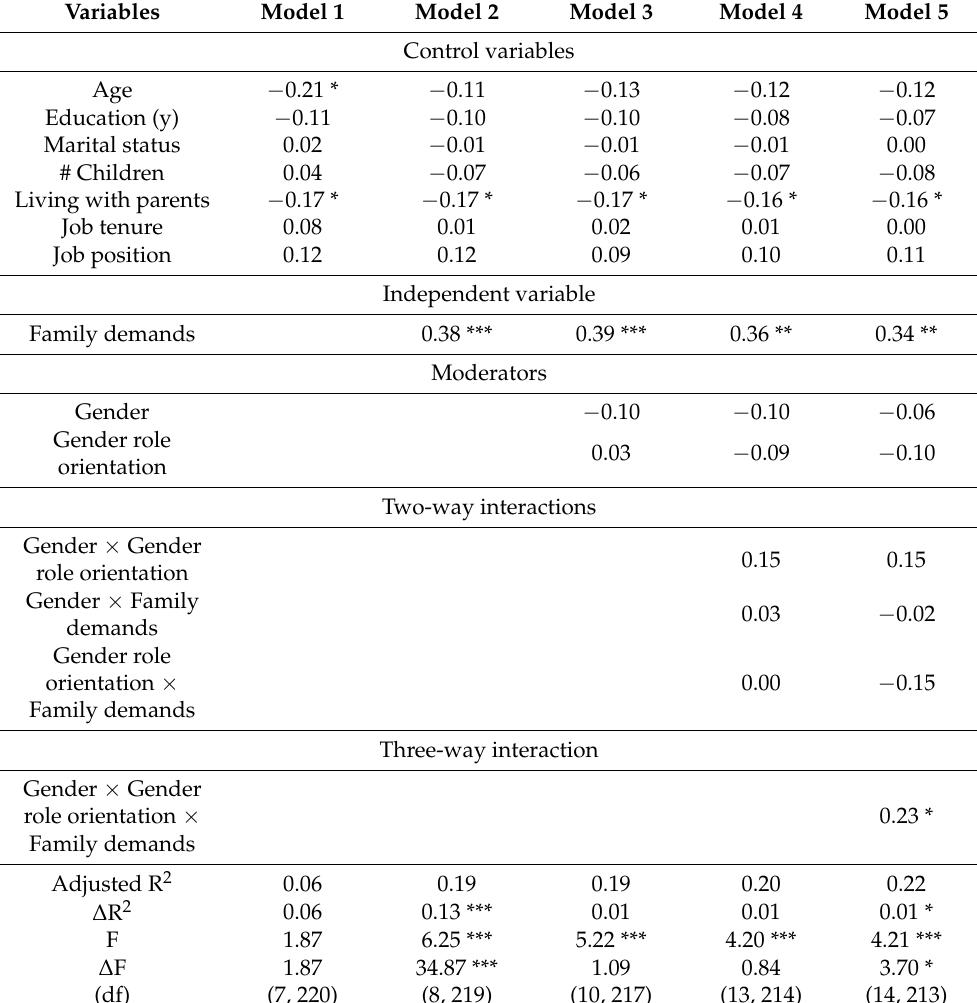
Table 4. Interactive effects of gender, gender role orientation, and family demands on family-to-work conflict (N =